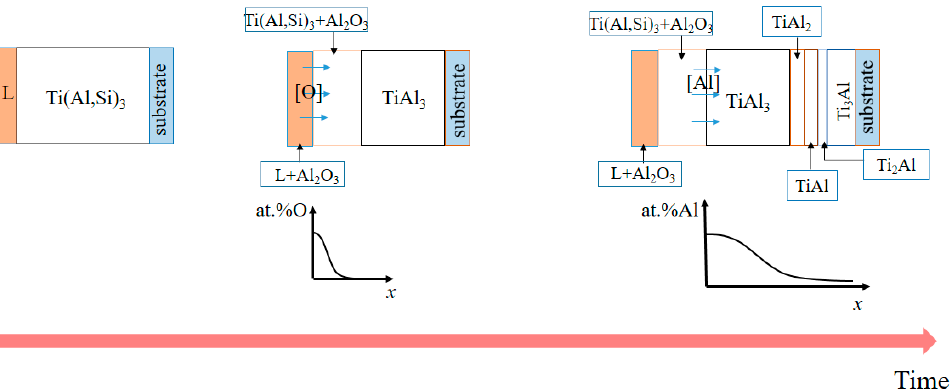
Figure 7. Schematic diagram of the high-temperature oxidation mechanism.